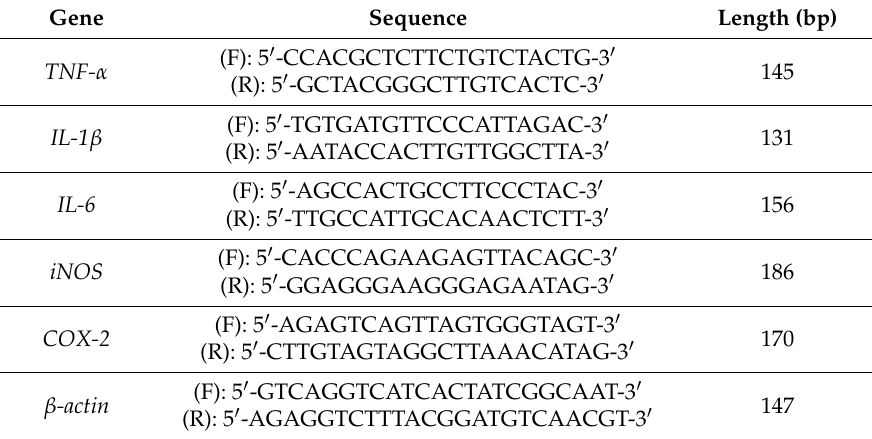
Table 2. The primer sequences of TNF- α , IL-1 β , IL-6 , iNOS , COX-2 , and β -actin